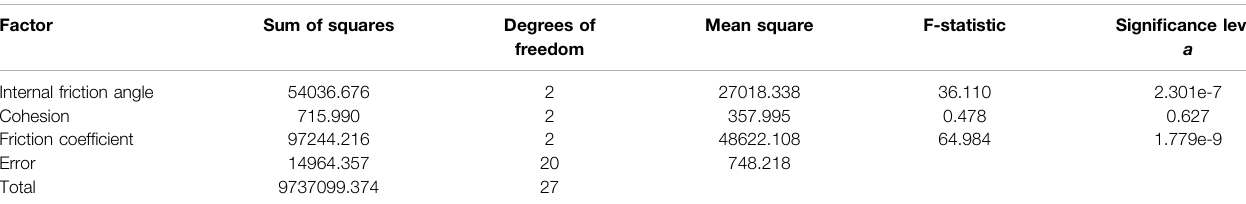
TABLE 4 | Variance analysis results for average